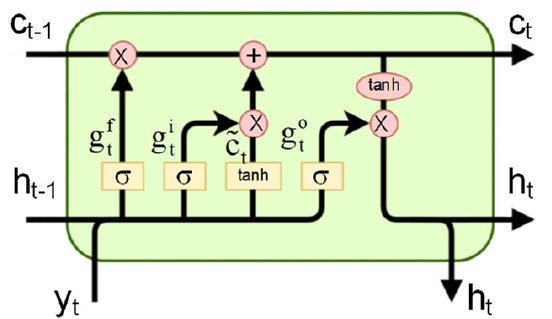
Figure 3. Structure of the LSTM unit.